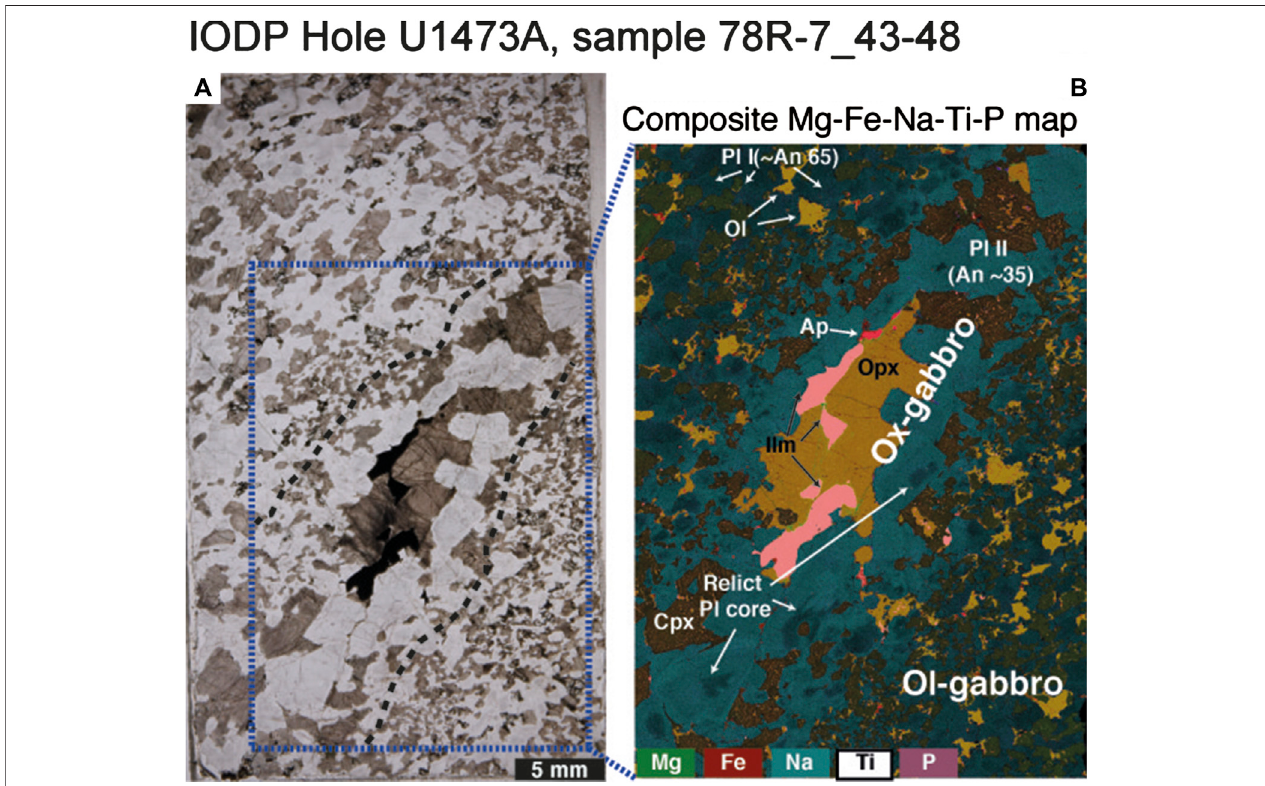
FIGURE 2 | (A) Photomicrograph and (B) composite Mg-Fe-Na-Ti-P compositional map of sample U1473A-78R-7_43 – 48. Dashed black lines contour the Ox- gabbro seam and delineate the boundary between the two regions displaying chemical variation in mineral compositions. Note that plagioclase cores with An compositions comparable to that of the host Ol-gabbro are preserved in the Ox-gabbro. Cpx, clinopyroxene; Ilm, ilmenite; Ol, olivine; Opx, orthopyroxene; Pl, plagioclase.